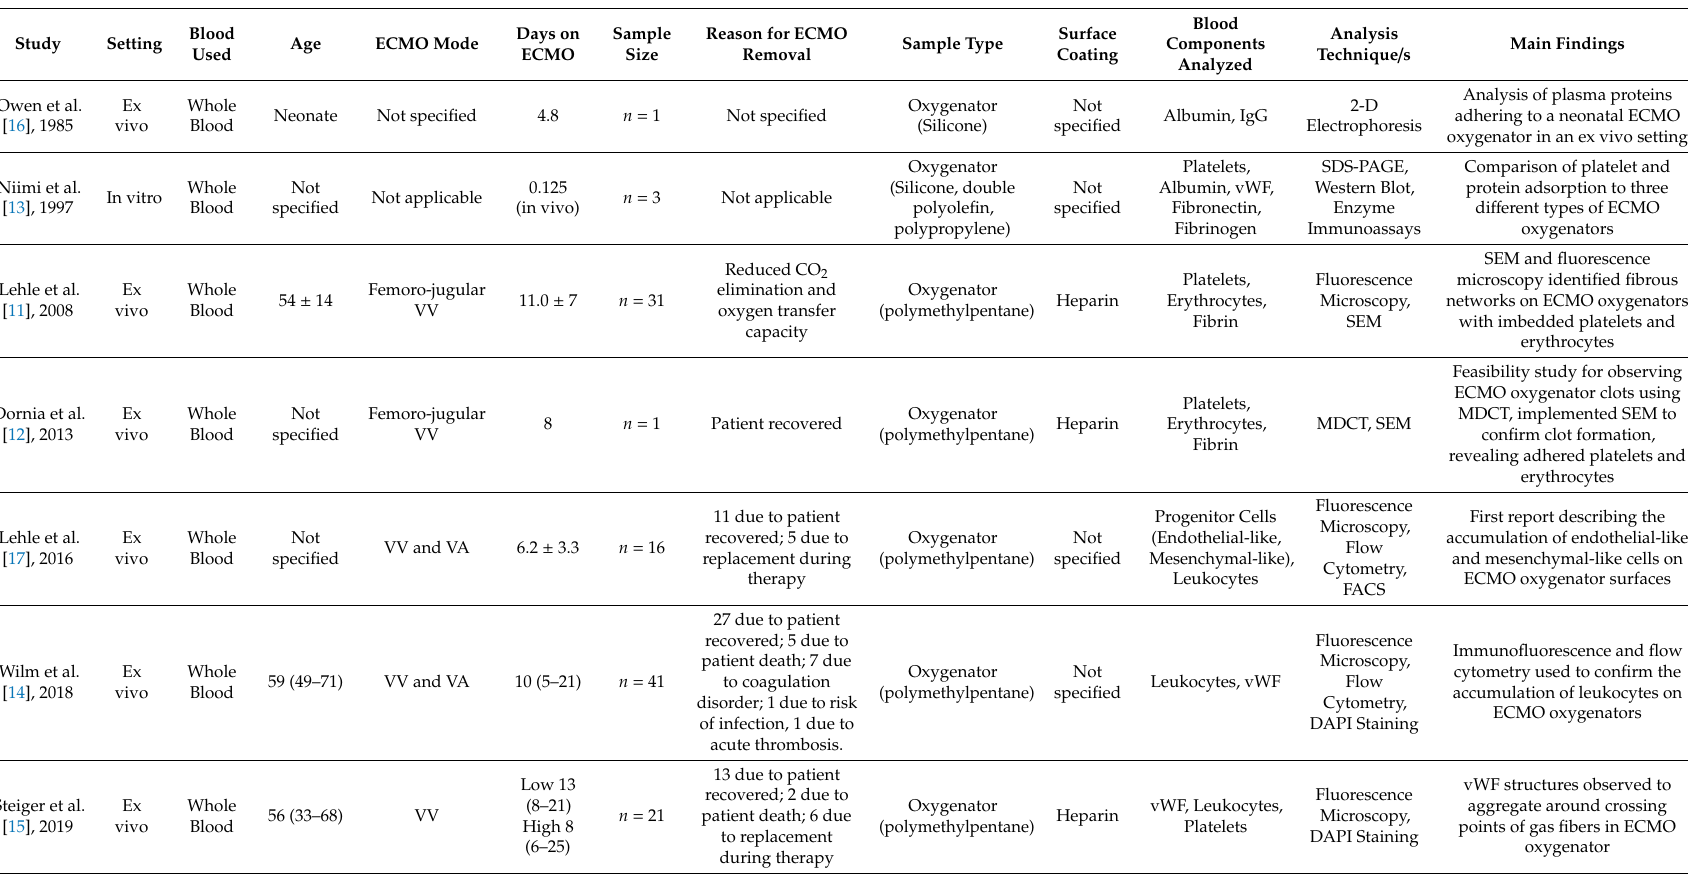
Table A3. Summary of the studies included in the systematic review for the adsorption of blood components onto ECMO circuit